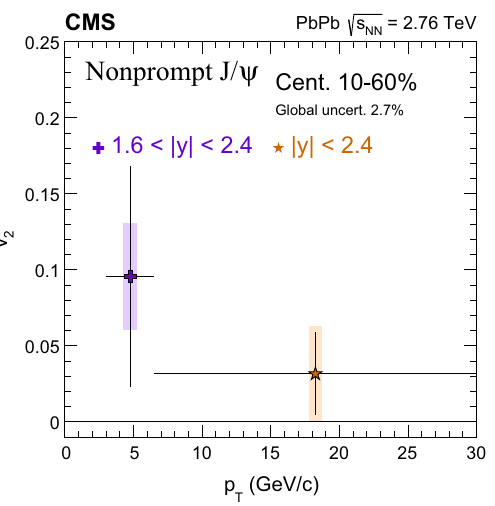
Fig. 6 Nonprompt J /ψ v 2 as a function of p T . The bars ( boxes ) rep- resent statistical (systematic) point-by-point uncertainties. The global uncertainty, listed in the legend, is not included in the point-by-point uncertainties. Horizontal bars indicate the bin width for 1 . 6 < | y | < 2 . 4, the p T dependence of R AA vs. N part .